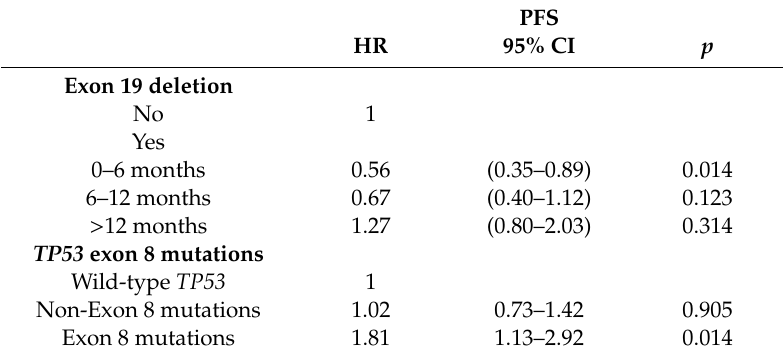
Table 3. Multivariate Cox analysis of progression-free survival (PFS) ( n =